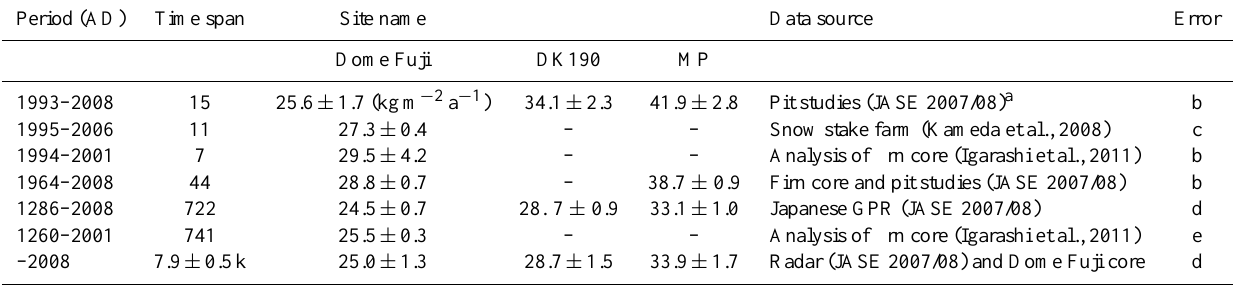
Table 3a. Annual accumulation rates derived for Dome Fuji, DK190 and MP. Period (AD)